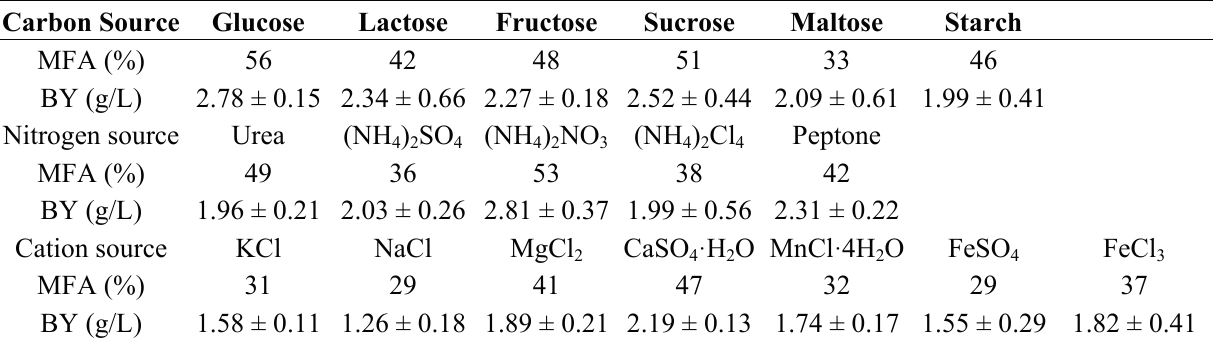
Table 1. Nutritional sources optimally utilized by mixed culture of Brachybacterium sp. and Streptomyces sp. for the production of